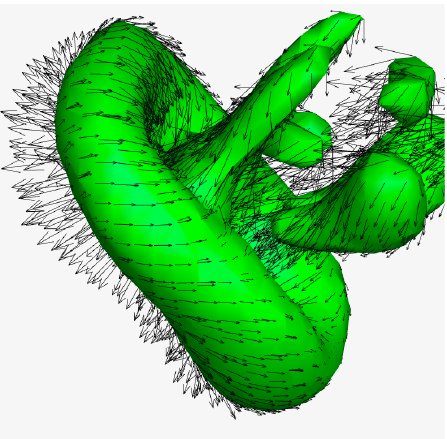
Figure 4. Development of the vortex structure in the jet flow region across the width of the mold at different times of ( a ) 0.2 s, ( b ) 0.3 s, ( c ) 0.4 s, and ( d ) 0.5 s.